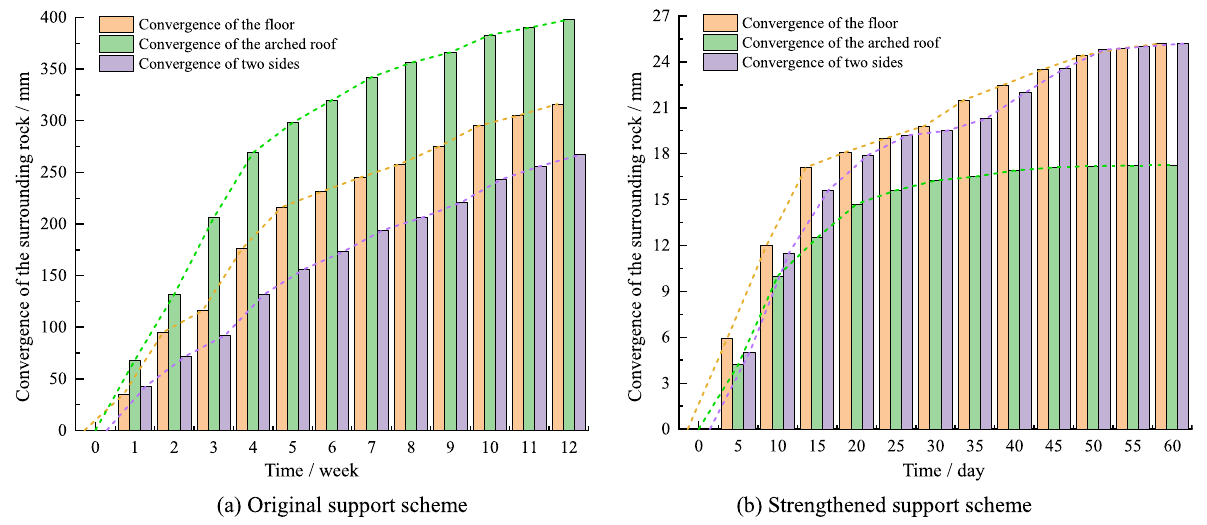
Fig. 27 Comparison of deformation convergence between original support and reinforced support roadway